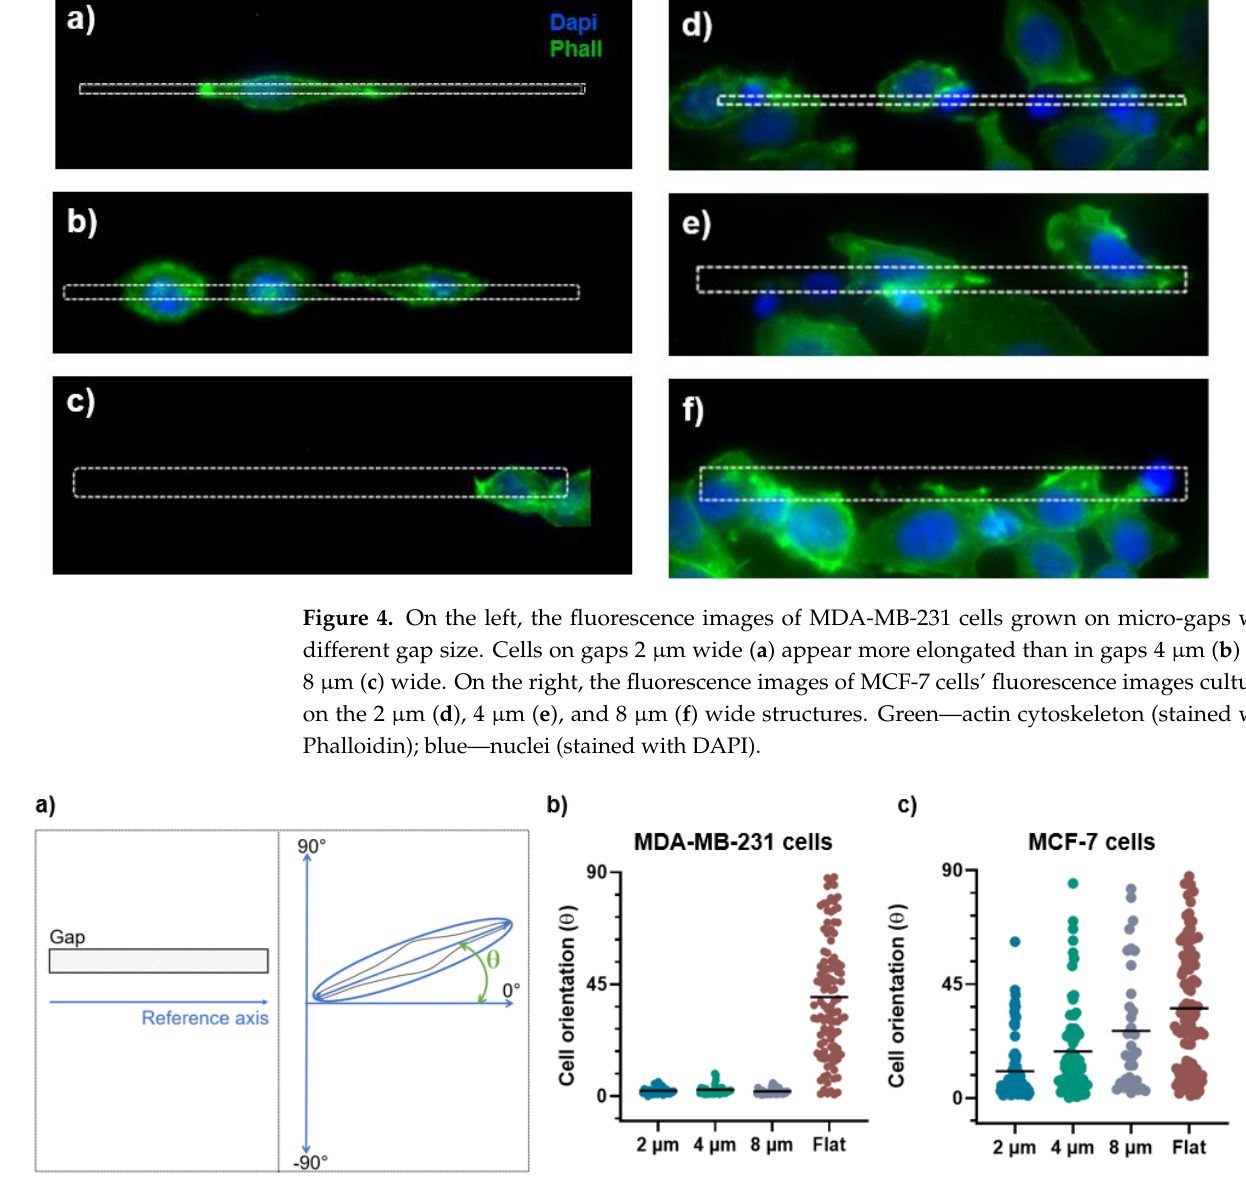
Figure 4. On the left, the fluorescence images of MDA-MB-231 cells grown on micro-gaps with dif- ferent gap size. Cells on gaps 2 μm wide ( a ) appear more elongated than in gaps 4 μm ( b ) and 8 μm ( c ) wide. On the right, the fluorescence images of MCF-7 cells ’ fluorescence images cultured on the 2 µm ( d ), 4 µm ( e ), and 8 µm ( f ) wide structures. Green — actin cytoskeleton (stained with Phal- loidin); blue — nuclei (stained with DAPI).